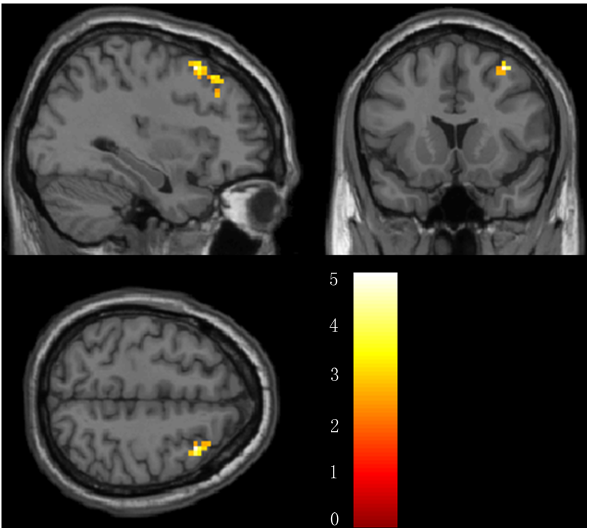
Figure 7. Brain regions showing altered connectivity to left or right hippocampus in AD group after acupuncture comparing to before acupuncture. The right MFG showed increased connec- tivity to left hippocampus in AD patients after acupuncture. Left in picture is left in the brain. The color scale represents t values.